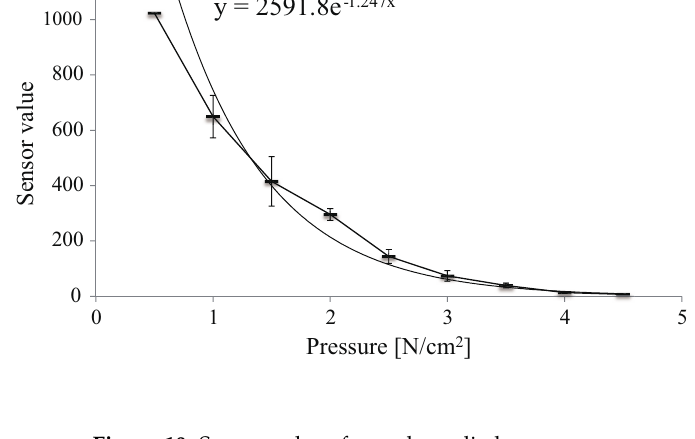
Figure 10. Sensor values for each applied pressure.